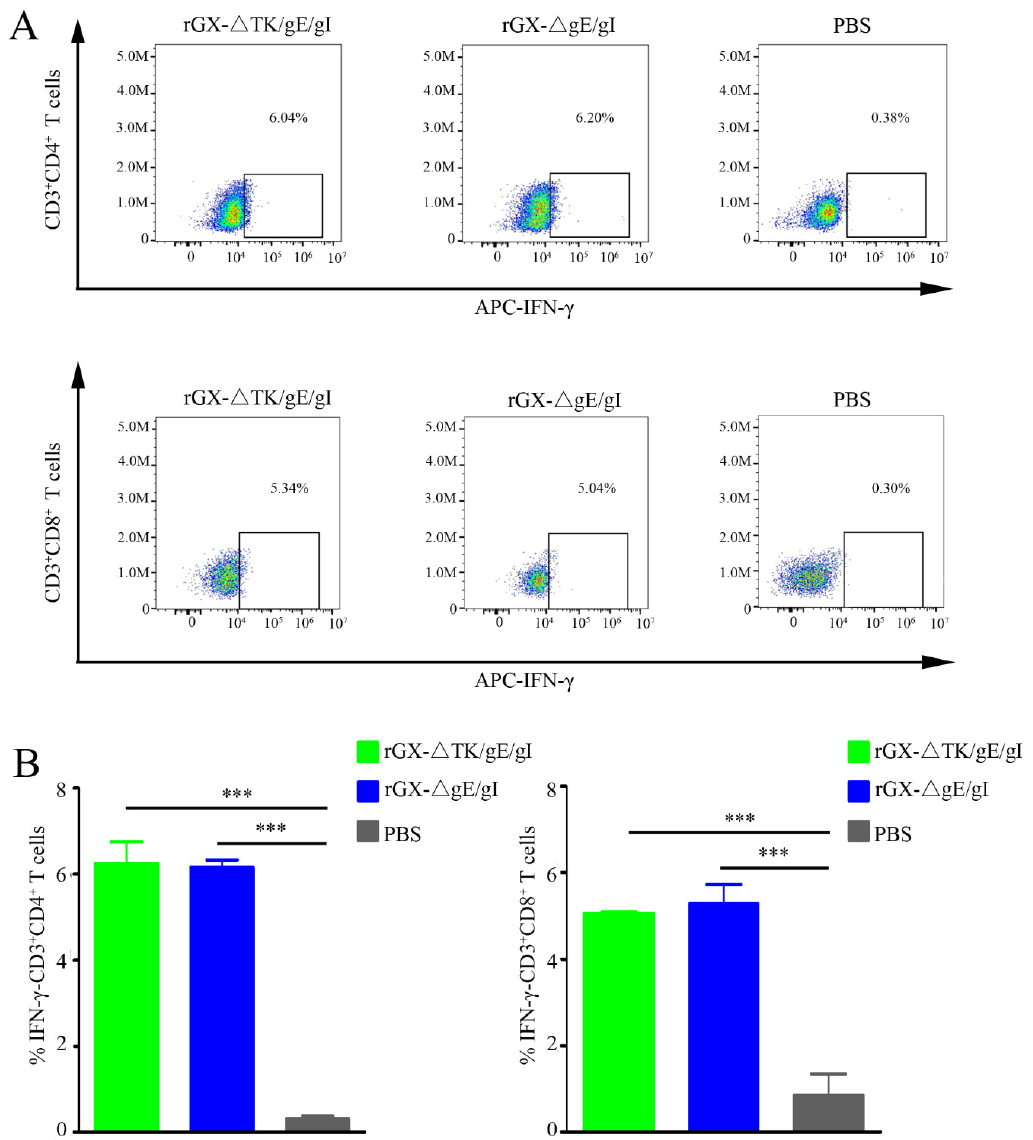
Figure 4. The rGX Δ gE/gI or rGX Δ TK/gE/gI facilitated production of IFN- γ -producing CD4+ and CD8+ T-cells in the blood. ( A ) Flow cytometry analysis was used to measure the IFN- γ -producing CD4+ and CD8+ T-cells. ( B ) The calculation of IFN- γ -producing CD4+ and CD8+ T-cells. n = 4. *** p <